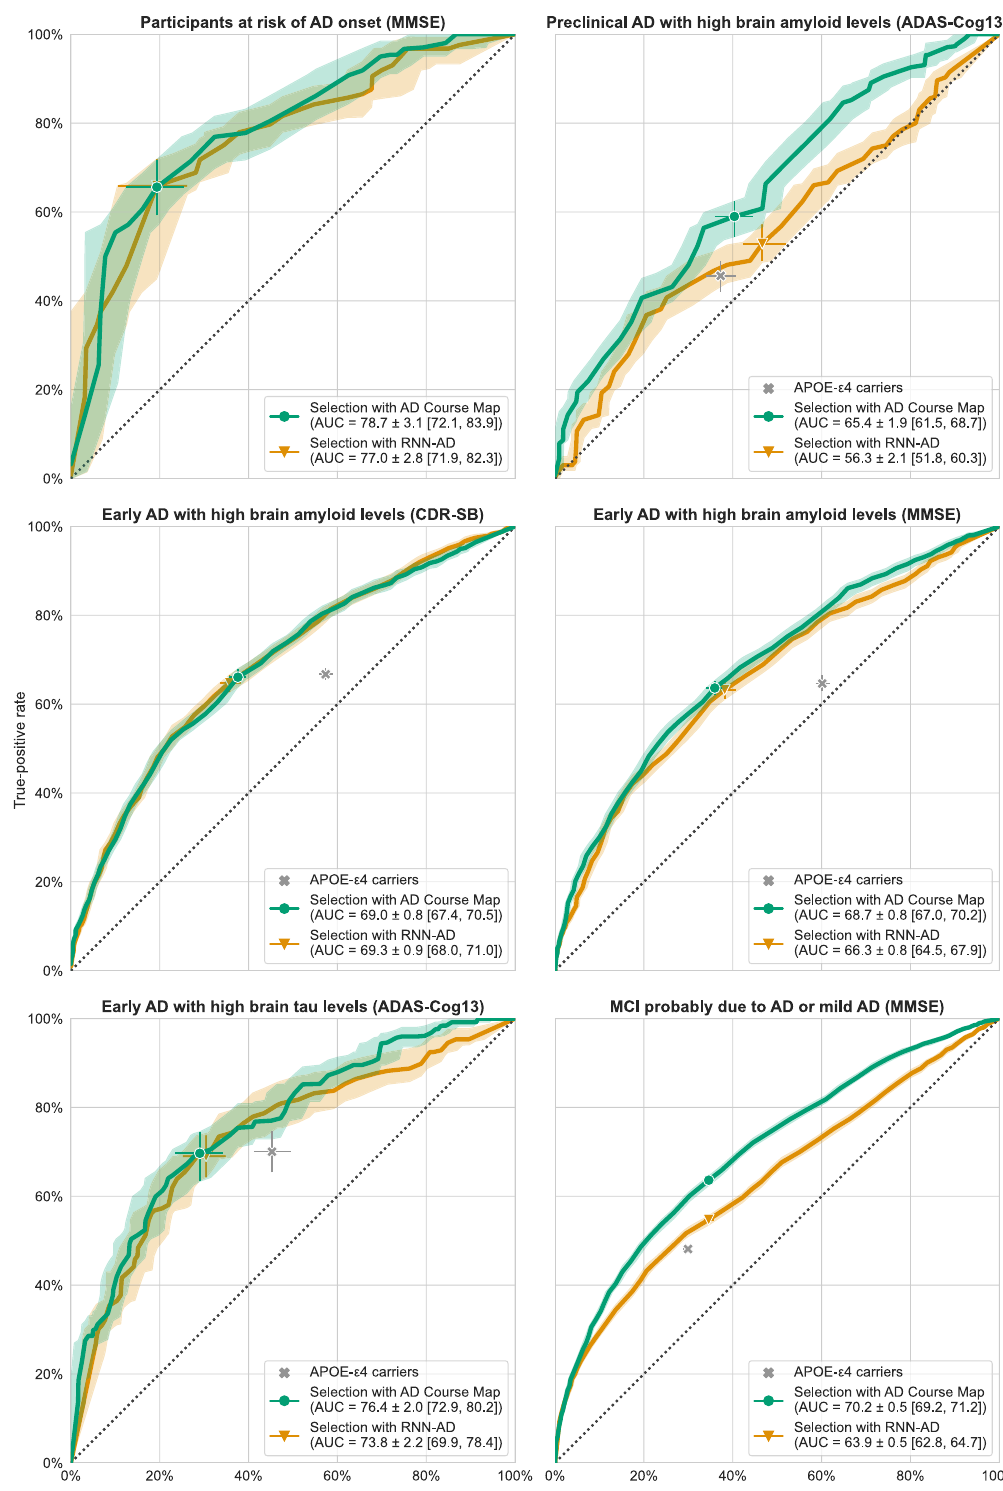
Fig.5|ADCourseMapandRNN-ADselectparticipantsatriskofexperiencinga worsening of the outcome during the trial. Receiver operating characteristic (ROC) curves are shown. They demonstrate the performance of AD Course Map and RNN-AD in selecting the group of participants with the largest change in pri- mary outcome during follow-up. Shaded areas correspond to the empirical 95% con fi denceinterval.Thegreencircleandorangetriangleoneachcurvecorrespond to selections splitting the participants into two equal groups, with bars